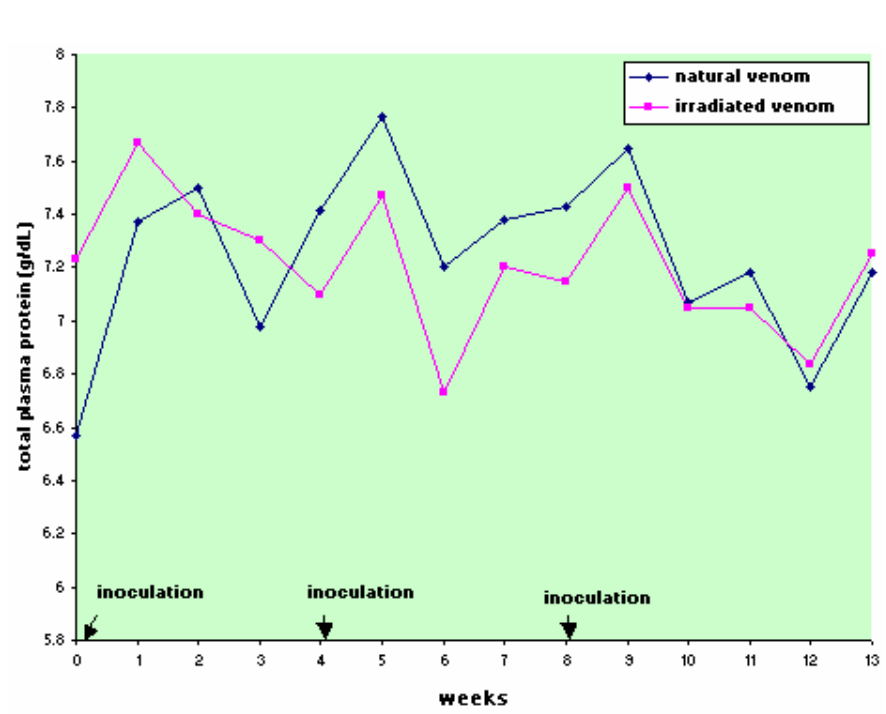
Figure 6. Mean values of total plasma protein levels (g/dL) in sheep (n=12) inoculated with -irradiated (IrV) crotalic venom. natural (NV) Cobalt 60